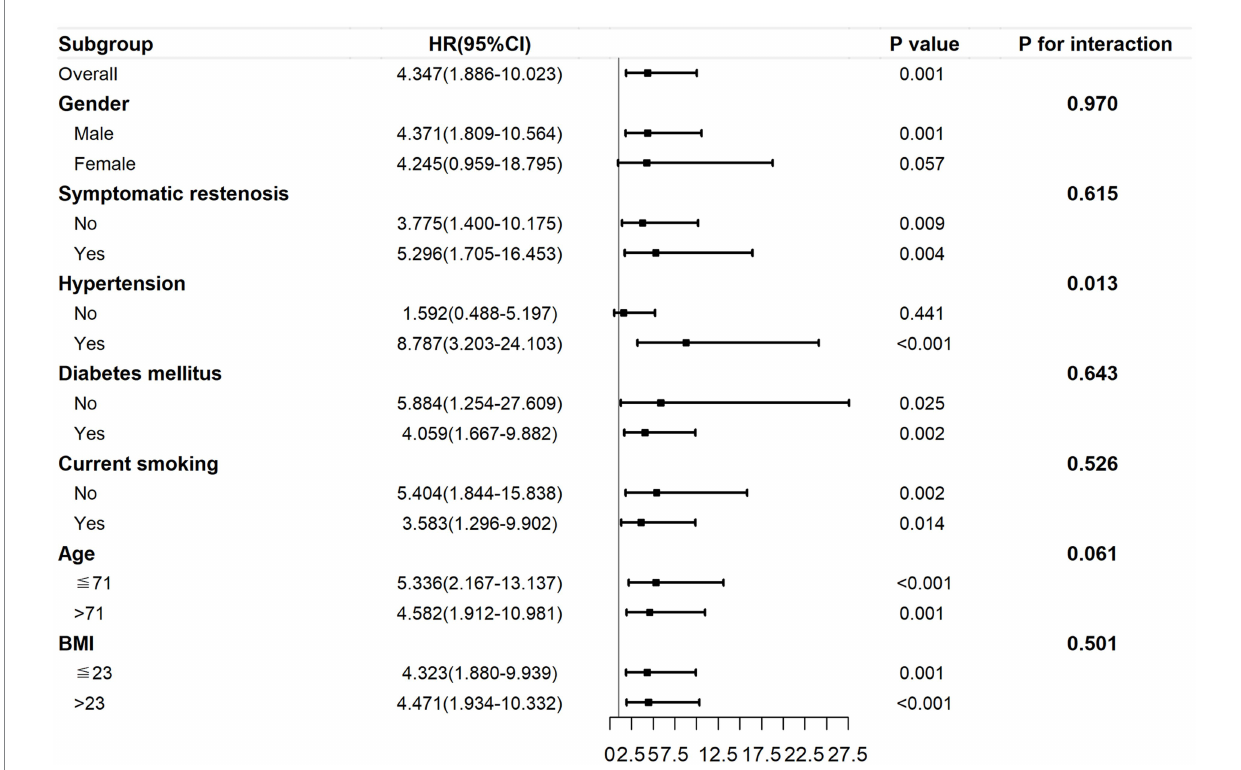
FIGURE 6 The subgroup analysis of the association between the preoperative TyG index and ISR within 29 months post-surgery. The TyG index was adjusted for variables with p < 0.2 in univariate Cox regression and variables with potential clinical relevance. TyG, triglyceride–glucose; ISR, in-stent